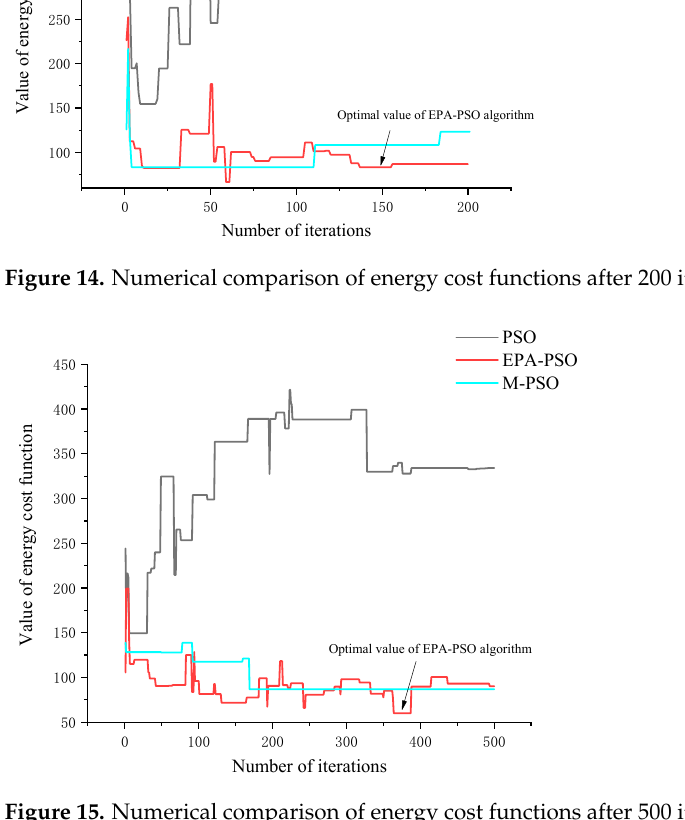
Figure 16. Numerical comparison of cost functions of radius of gyration after 100 iterations. 0 PSO EPA-PSO M-PSO Figure 17. Numerical comparison of cost functions of radius of gyration after 200 iterations.